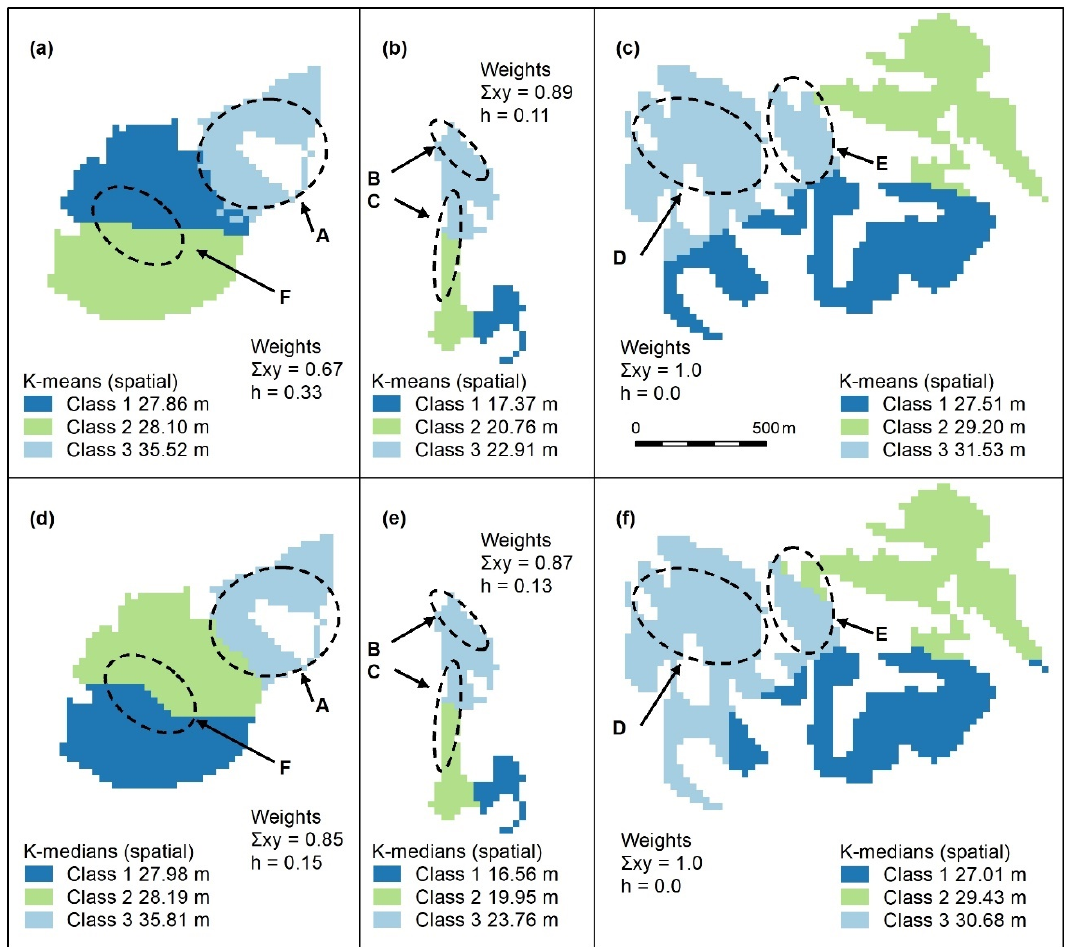
Figure A6. Spatially constrained K ‐ means ( a – c ) and K ‐ medians ( d – f ) cluster maps with 3 classes. Letters A–F indicate areas of higher canopy. Again, these algorithms use spatial weights ( x, y ) which outweigh those of the object ( h = height). The only features adequately captured by these algorithms are A ( a , d ) and E ( c , f ). Panel scores: K ‐ means = 9 and K ‐ medians = 9.